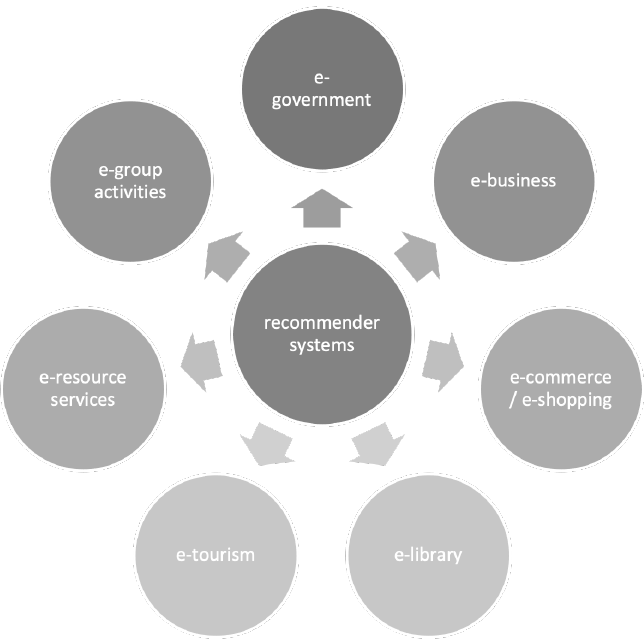
Figure 1. The application domains of recommender systems, based on the survey by